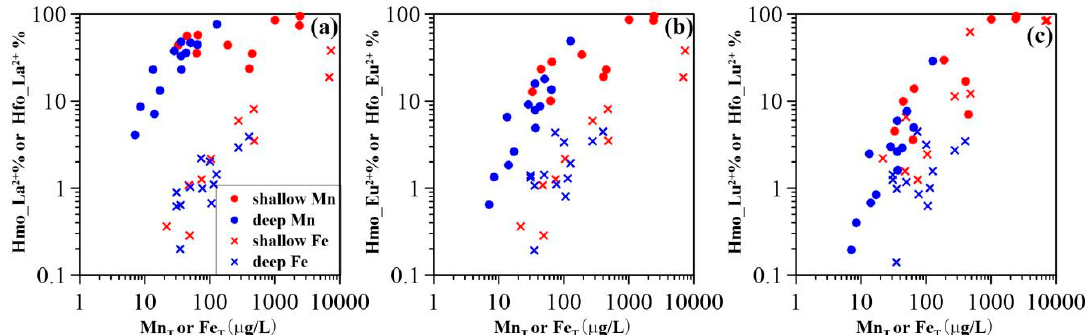
Figure 6. Proportion of ( a ) La, ( b ) Eu, and ( c ) Lu sorbed by HMO and HFO as a function of total Mn concentrations (Mn T ) and total Fe concentrations (Fe T ) (The sorbed La, Eu, and Lu were determined by modeling; Mn T and Fe T concentrations were determined by experiments).